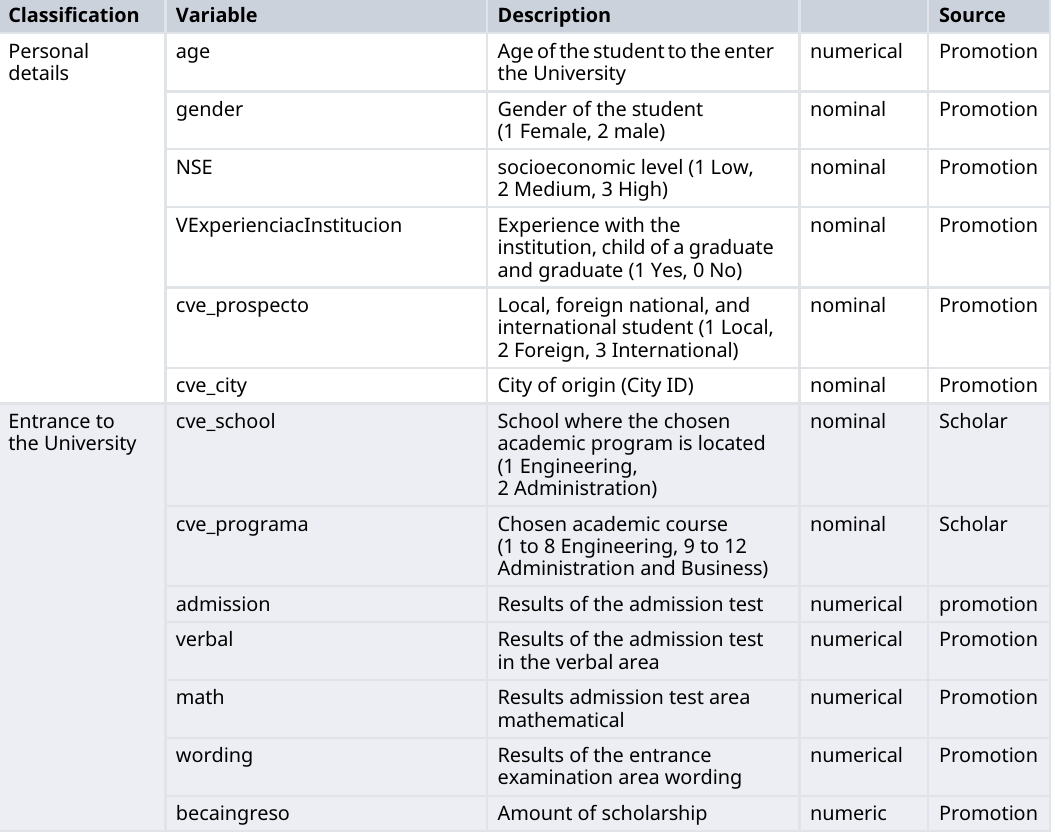
Table 1. Classification of data from the dropout student.